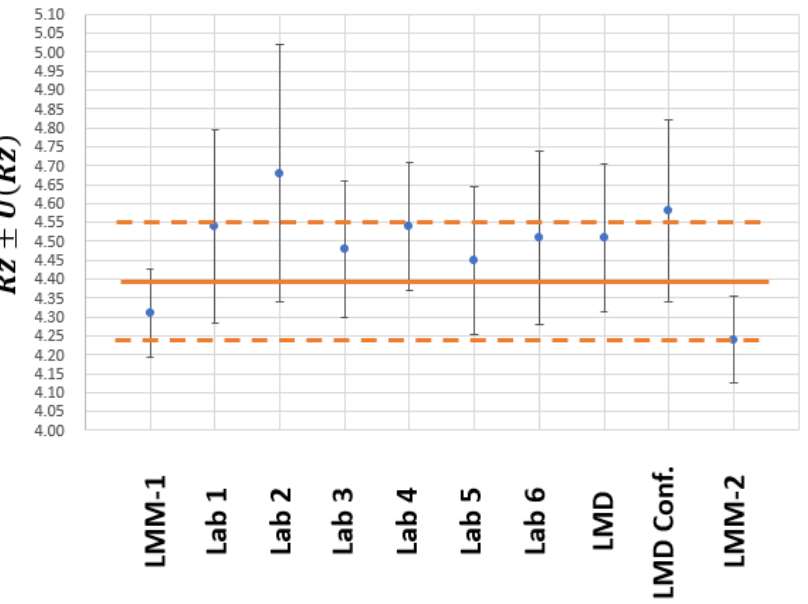
Figure 7. ILC results for Rz roughness parameter.